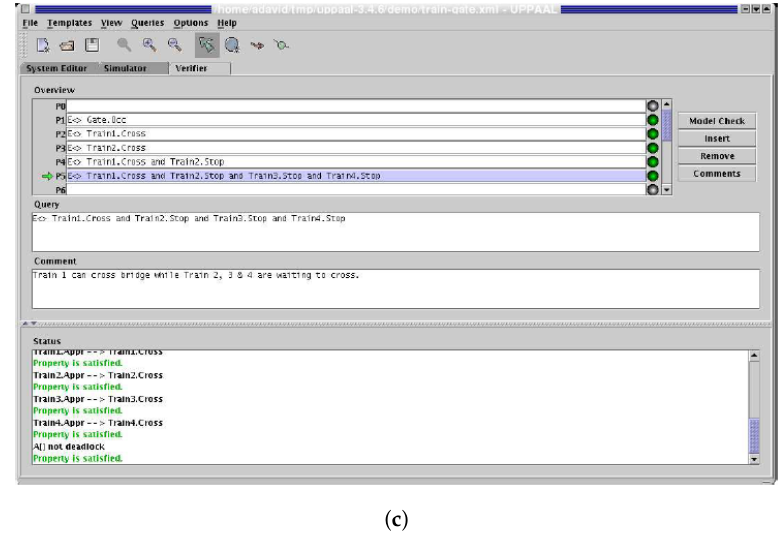
Figure 3. ( a )View of Uppaal’s Editor screen. ( b )View of Uppaal’s Simulator screen. ( c )View of Uppaal’s Verifier screen. Reproduced with permission from [33]. Copyright Springer Nature,